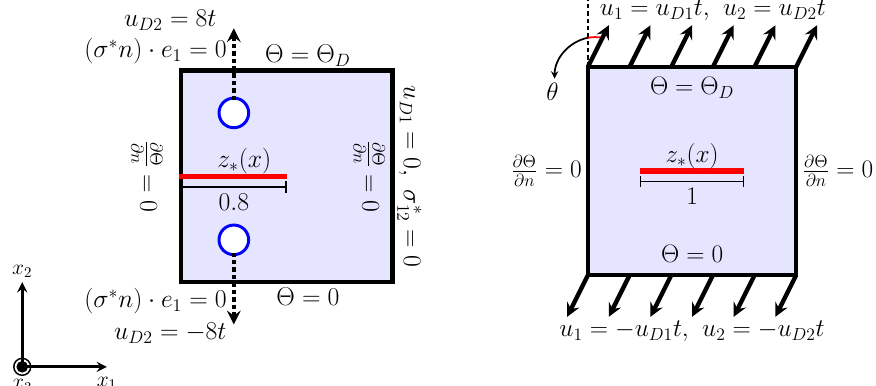
Figure 14. Mode I ( left ) and Mode I + II ( right ) for the study of the crack path under thermal expansion and the loading process. Here, the initial damage z ∗ ( x ) is illustrated by the red initial crack in the